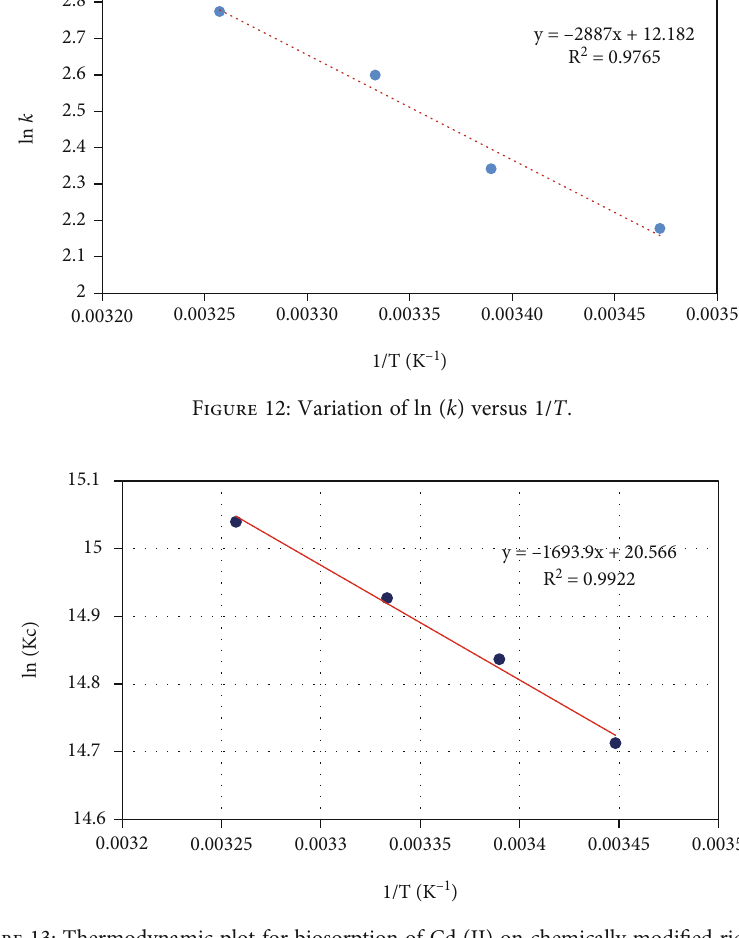
Figure 13: Thermodynamic plot for biosorption of Cd (II) on chemically modi fi ed rice